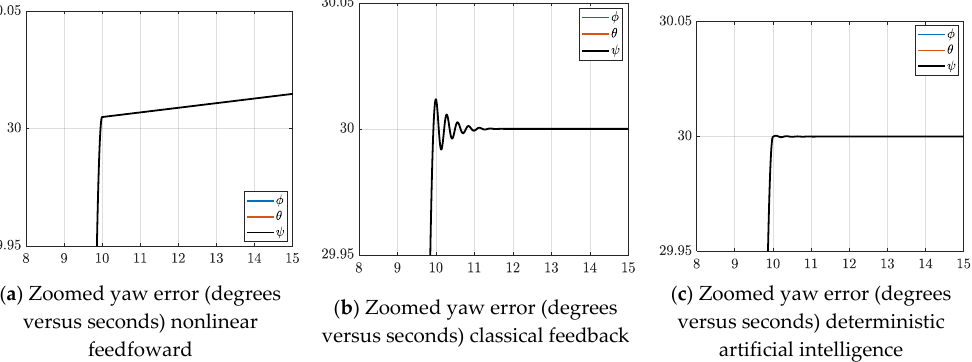
Figure 8. Change in angular position for all three controller configurations. (degrees versus seconds).